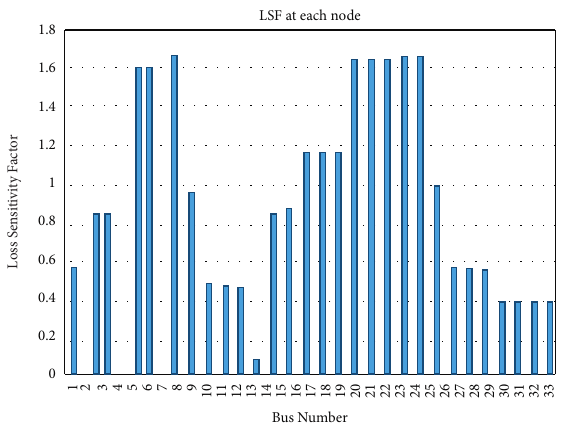
Figure 9: LSF at each node IEEE-34 bus